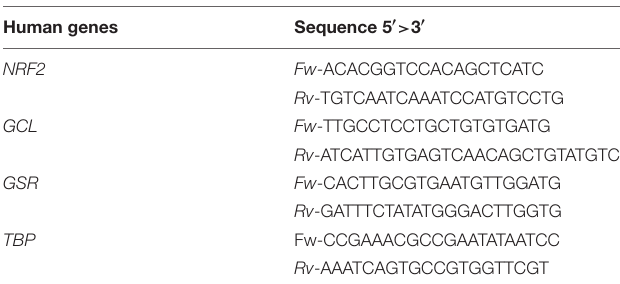
TABLE 1 | Primers used for